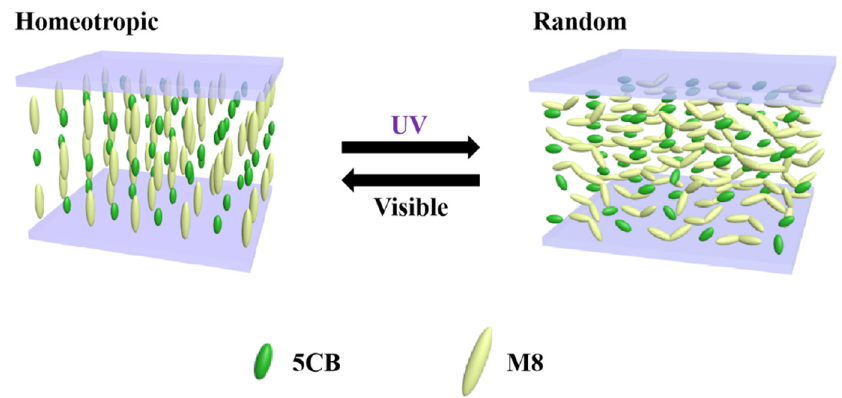
Figure 9. Illustration of the mechanisms of homeotropic and planar alignments.